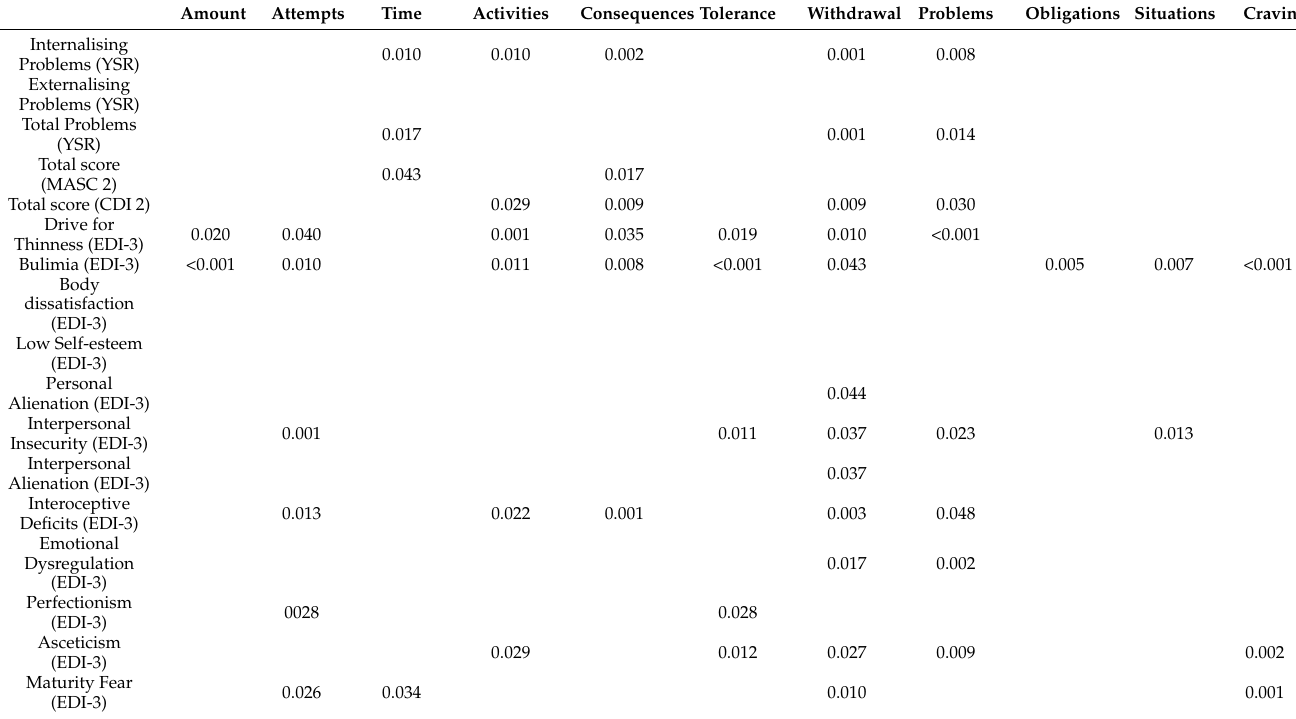
Table 3. Association between FA symptoms and psychopathological